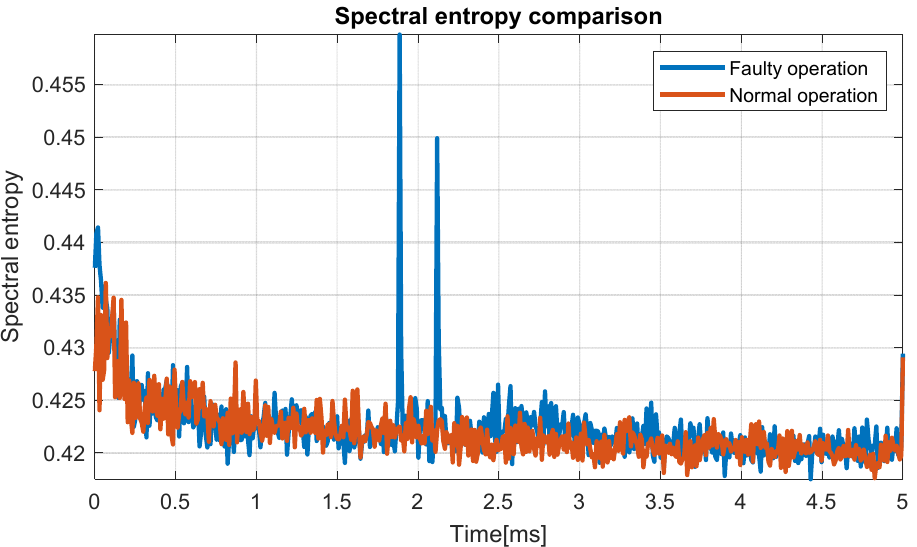
Figure 8. The spectral entropy of the two analyzed states of the system. With the help of the phase diagram-based entropy, the appearance of partial discharges in the network is highlighted. As can be seen in Figure 9, the two maxima of the phase diagram-based entropy render the two specific moments of the occurrences of the faults. The threshold used is a sensitive parameter and, depending on its value, the result has a more or less high accuracy. In order to calculate the phase diagram-based entropy, a value of 0.6 from the sliding window variance was used.